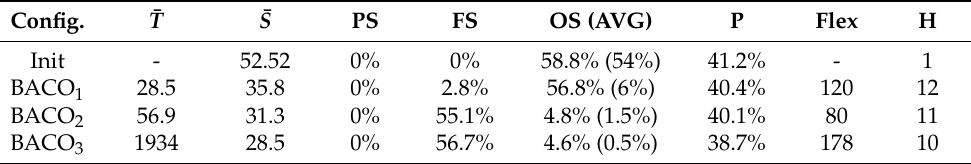
Table 5. Results for algorithm runs with average time ¯ T and the achieved average score ¯ S . The amount of unsupplied (US), partially supplied (PS), fully supplied (FS), oversupplied (OS), and producer (P) holon objects. The value AVG denotes the severity of the oversupply situation. Flex denotes the number of used flexibilities and the number of holons is shown as